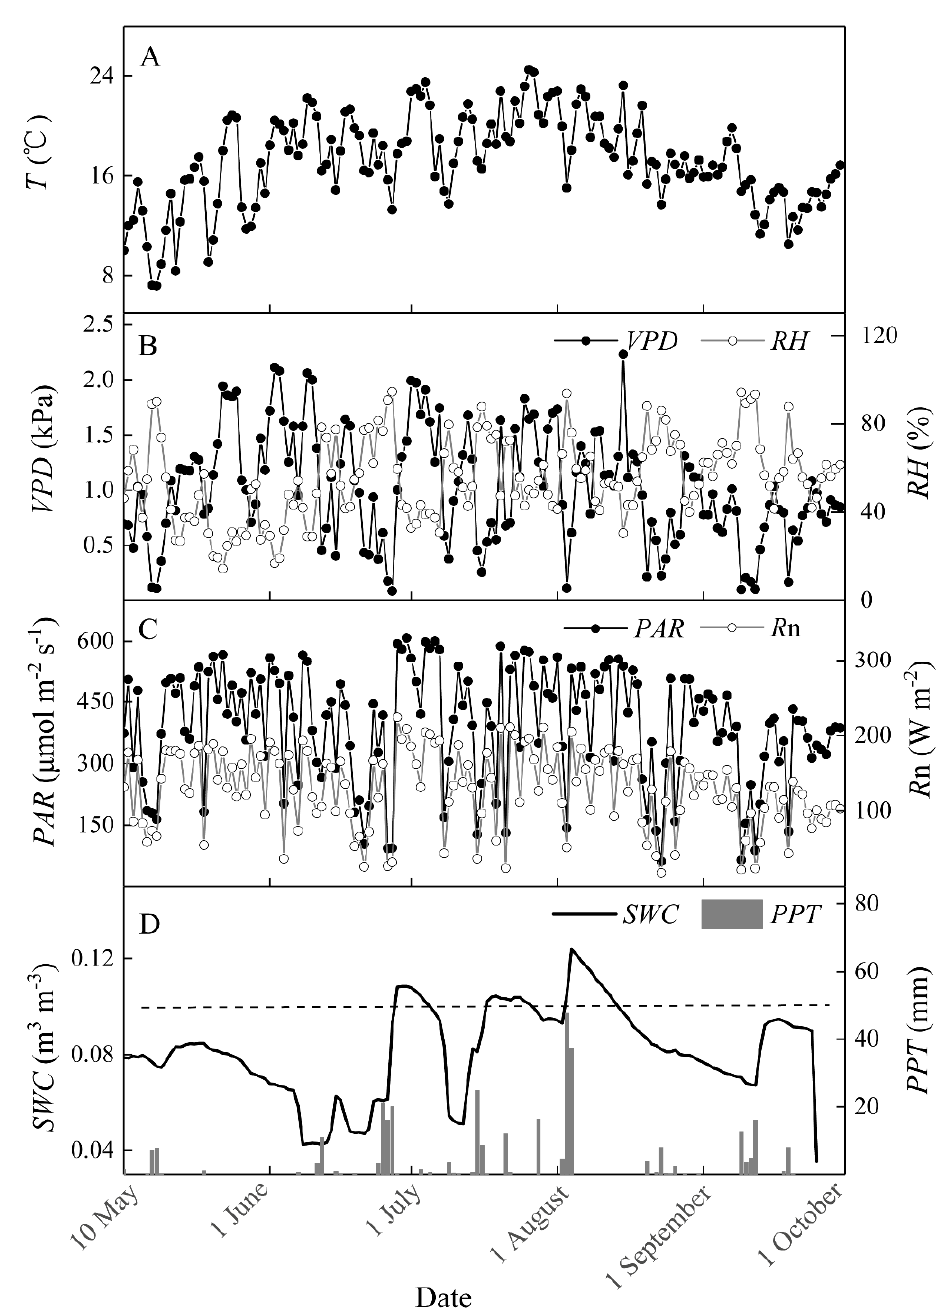
Figure 2. Temporal variation in daily mean air temperature ( T , ( A )), relative humidity ( RH ) and water vapor pressure deficit ( VPD , ( B )), net radiation ( R n) and incident photosynthetically active radiation ( PAR , ( C )), and soil water content ( SWC ) and daily total precipitation ( PPT , ( D )) during a five-month field campaign from 1 May − 30 September 2019. The horizontal dashed line in subfigure D represents the 0.10 m 3 m − 3 threshold assigned for SWC .